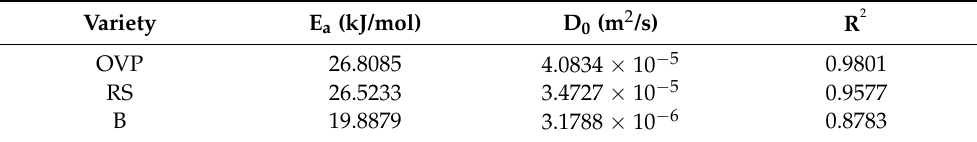
Table 5. Fitting parameters of the Arrhenius equation for germinated faba bean